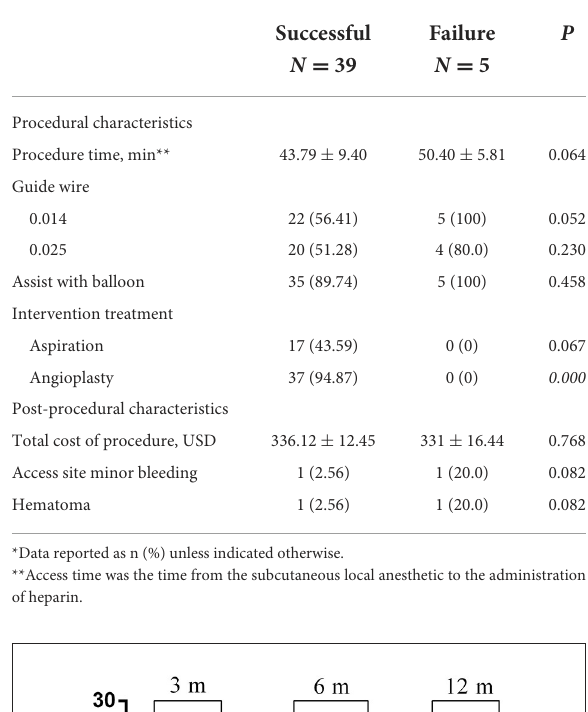
TABLE 2 Procedural and post-procedural characteristics of the successful and failure groups * .